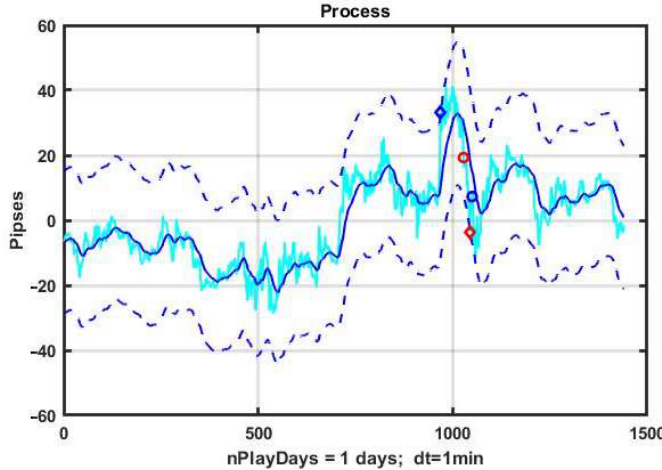
Figure 7. Example of CSF implementation on a subsequent one-day observation interval.